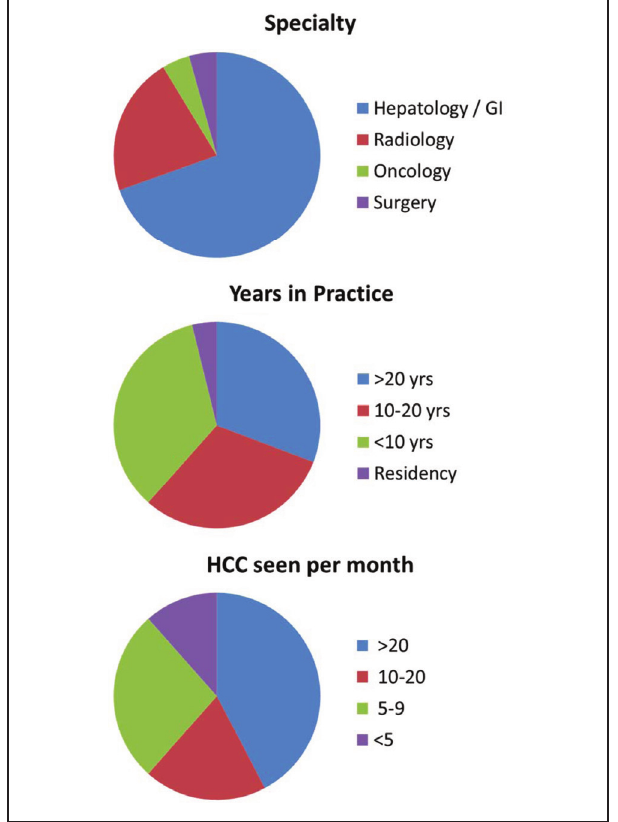
Figure 1) Demographics of voters. GI Gastroenterology; HCC Hepatocellular carcinoma; yrs Years